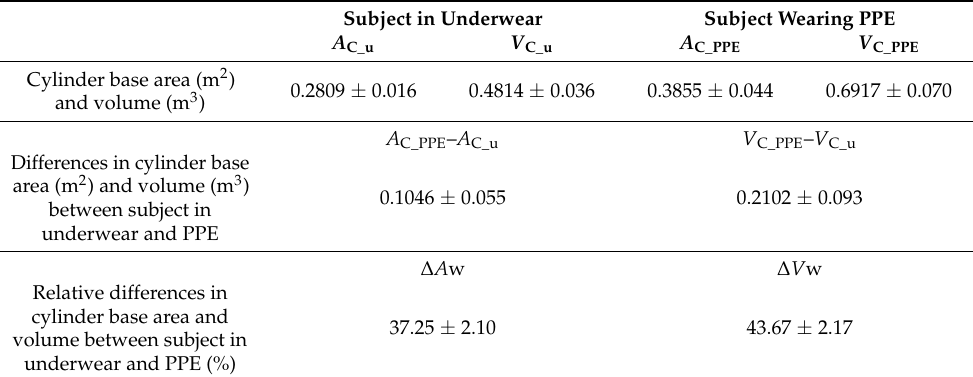
Table 4. Base areas and volumes of the human silhouette circumscribed by a cylinder as well as absolute and relative differences between the subject in underwear and PPE.